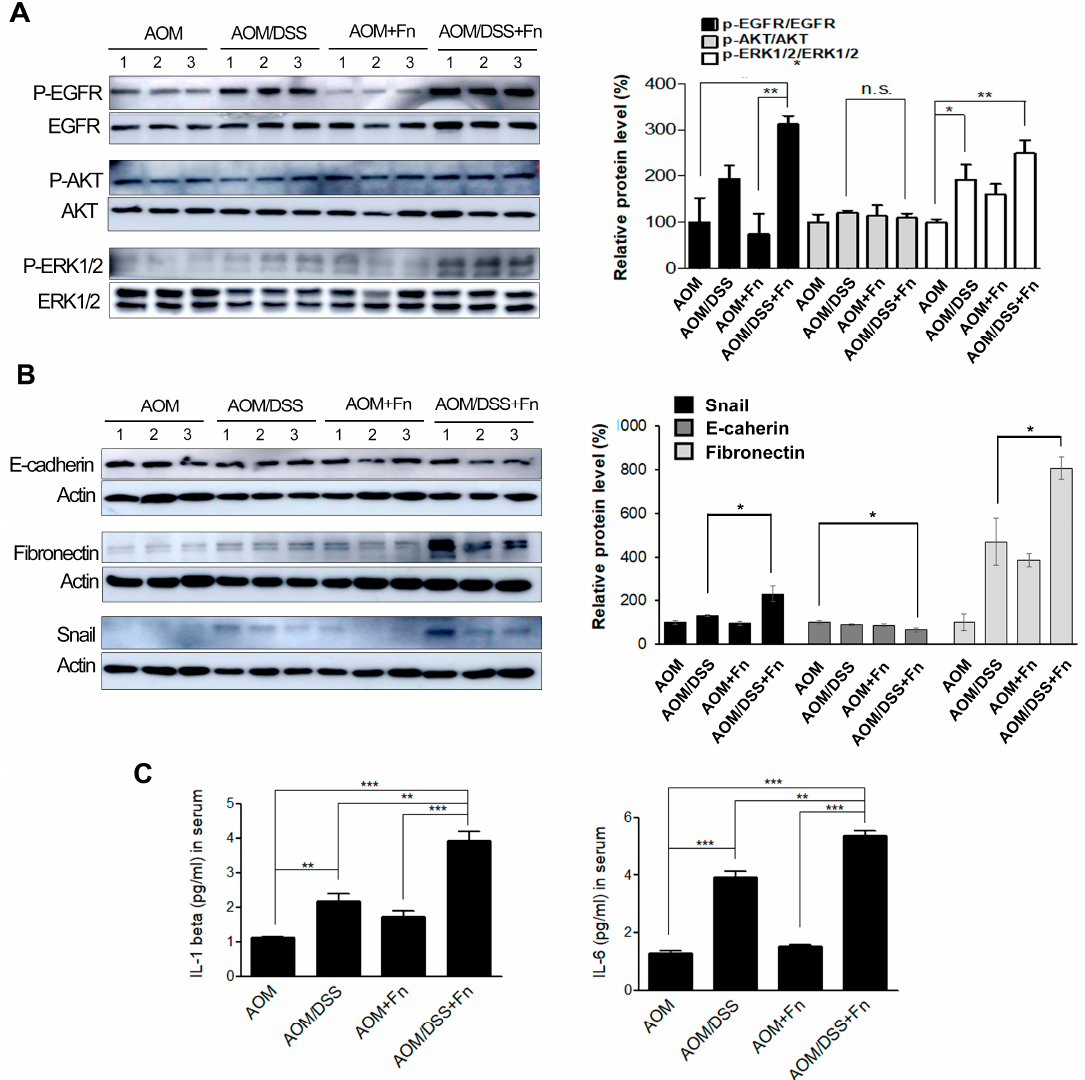
Figure 6. F. nucleatum triggers EMT of CRC cells in an AOM / DSS mouse model. ( A ) Phosphorylation levels of epidermal growth factor receptor (EGFR), protein kinase B (AKT), and extracellular signal-regulated kinase 1 / 2 (ERK1 / 2) in colonic tissues from each group were determined using Western blot analysis. Abbreviations: n.s, non significant. The Uncropped Western Blots are available in Figure S7. ( B ) The expression levels of Snail, E-cadherin, and fibronectin in colonic tissues from each group were determined using Western blot analysis. Graphs of the results of the analyses of the indicated proteins. * p < 0.05 compared to the AOM / DSS group. The graph represents relative protein levels obtained from three independent experiments. Densitometry of blots was followed by the calculation of relative protein levels compared with the control after normalization to beta-actin levels. ( C ) Effect of F. nucleatum on the levels of pro-inflammatory cytokines. The levels of interleukin IL-1 beta and IL-6 in serum from each group. The data are presented as the means ± SEM (** p < 0.01 and *** p < 0.005; unpaired Student’s t -test). The number of each group is 5. Abbreviations: AOM, azoxymethane; DSS, dextran sodium sulfate; Fn, F. nucleatum .